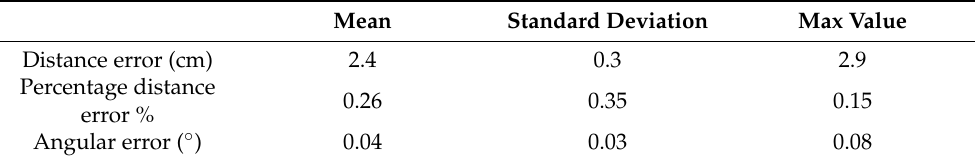
Table 3. Mean, standard deviation, and maximum value of distance error from point 1, percentage distance error, and angular error (point configuration for the double lane-change maneuver).